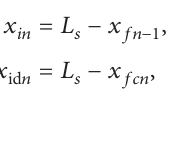
Figure 11: Changes of Num and Den with β